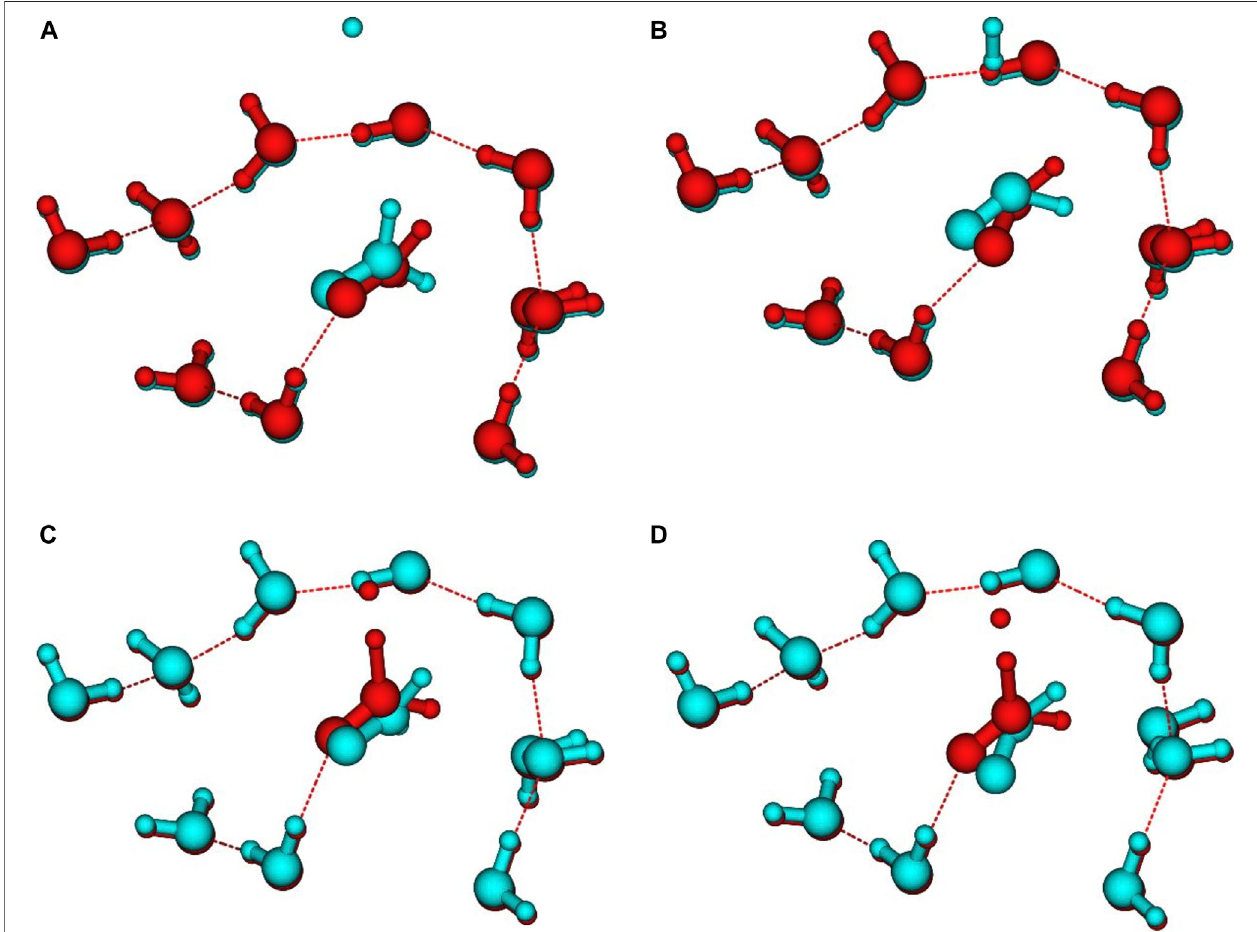
FIGURE 5 | Comparison between: (A) reactant (red) and last V MEP point (blue) geometries, (B) product (blue) and last V MEP point (red) geometries, (C) reactant (blue) and TS (red) geometries, (D) product (blue) and TS (red) geometries.